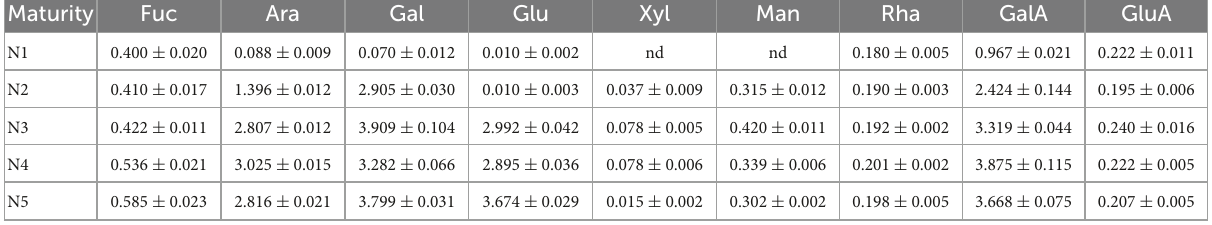
TABLE 3 Monosaccharide concentrations (mg/L) of Noni polysaccharide samples extracted at five stages of maturity. Maturity